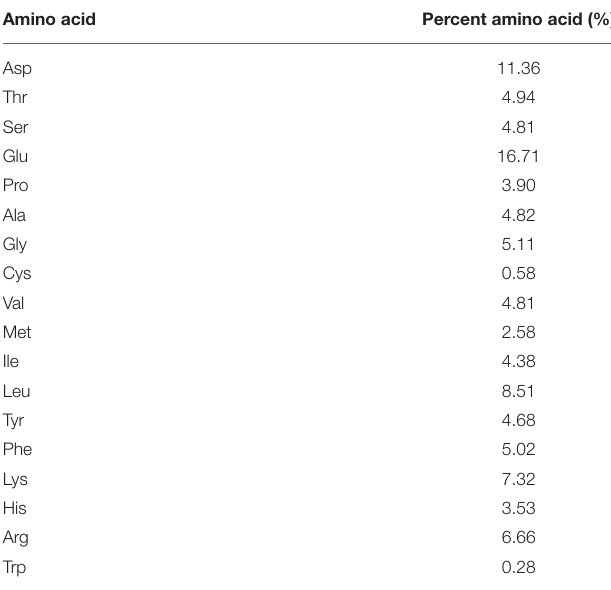
TABLE 1 | Amino acid composition of the proteins in the head of giant freshwater prawn. Amino